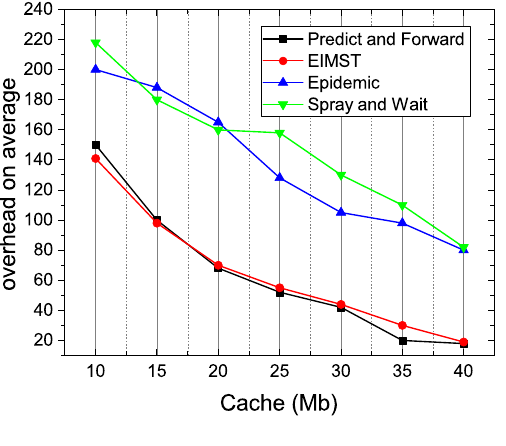
Figure 11. Overhead on average.